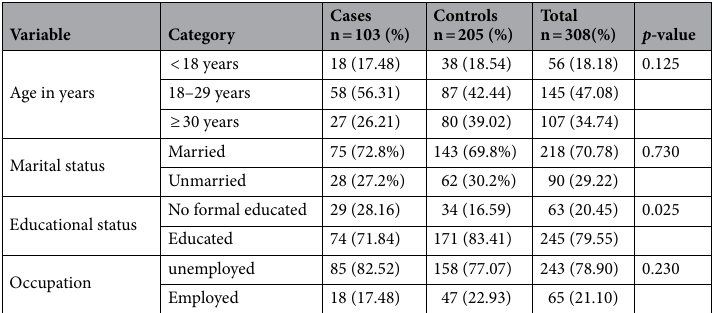
Table 1. Socio demographic characteristics of mothers who delivered atIlu Aba Bor, Public Hospitals, Ethiopia,